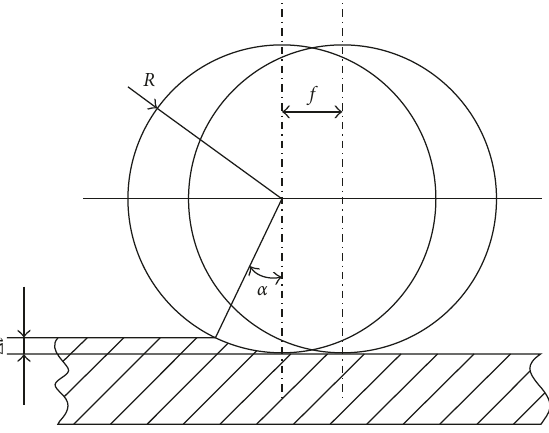
Figure 2: Process parameters for ball